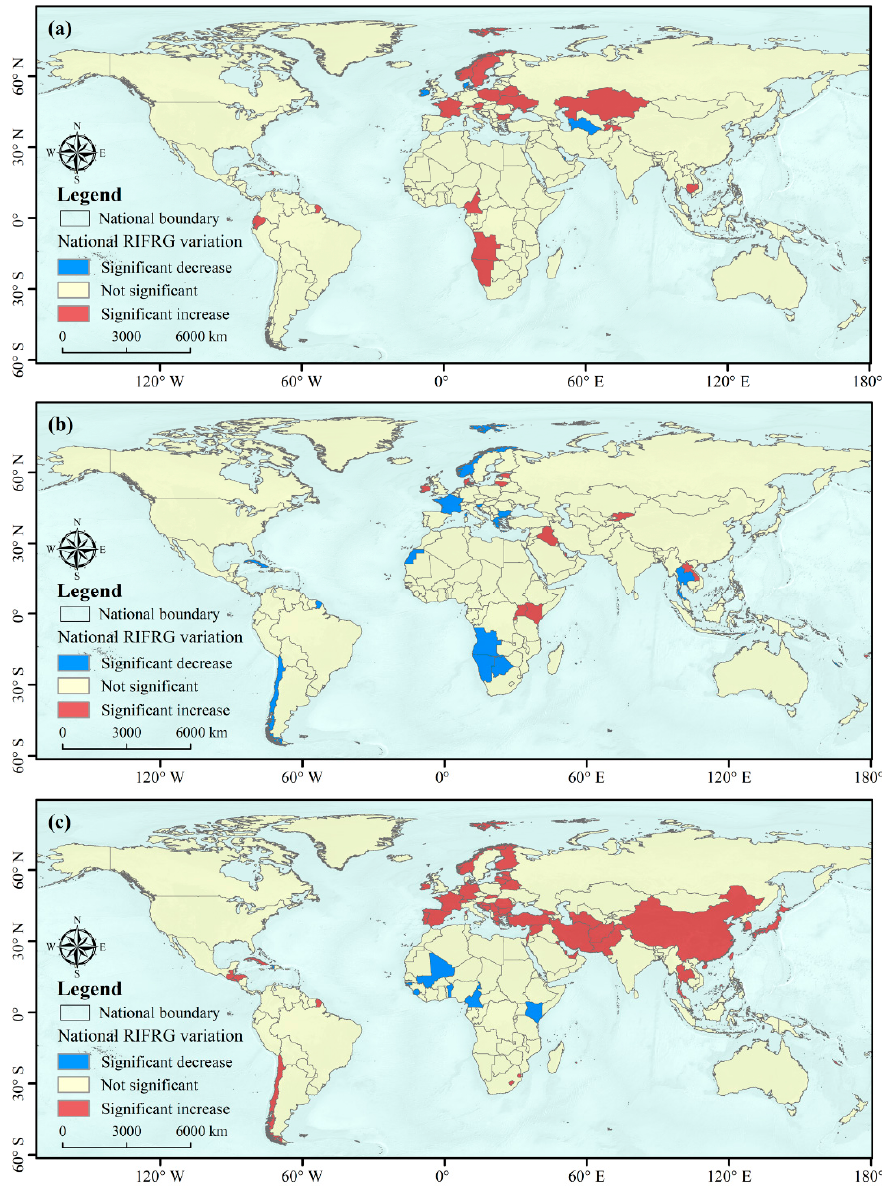
Figure 8. Spatial variations in the national RIFRGs across three time periods: ( a ) 2005–2010, ( b ) 2010– 2015, and ( c )